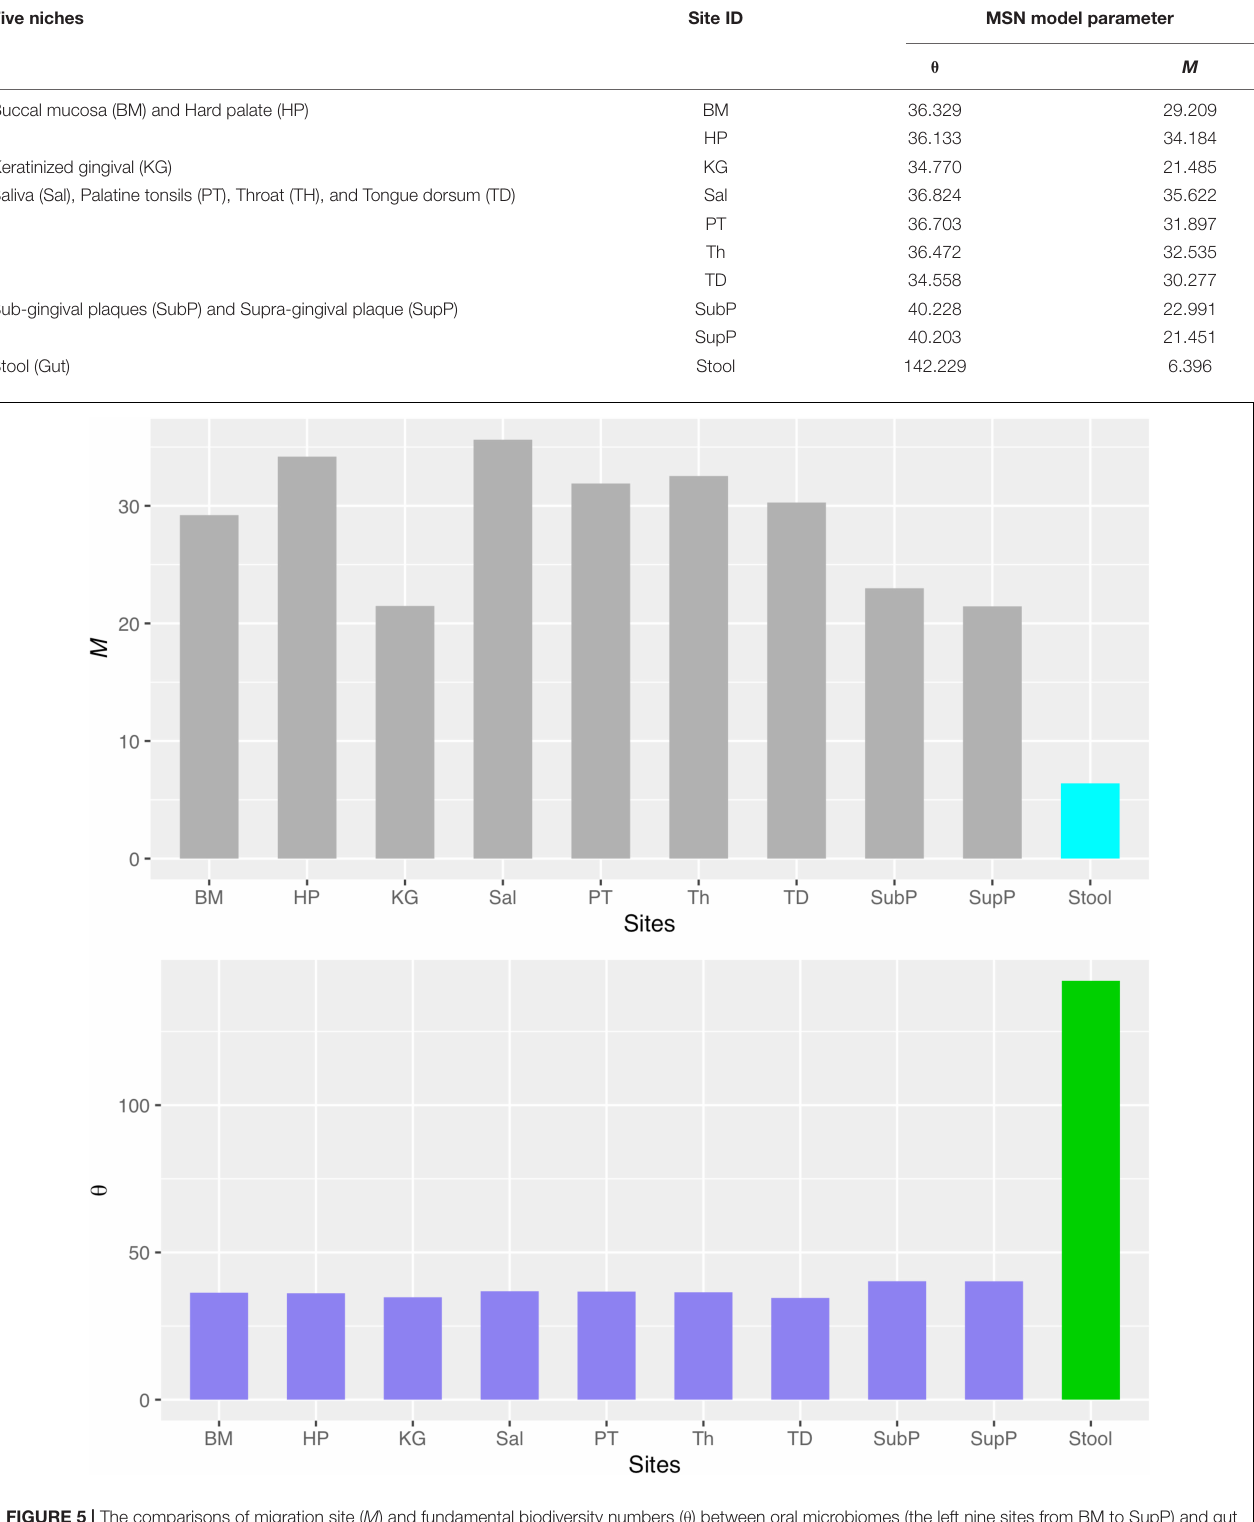
Frontiers in Microbiology |